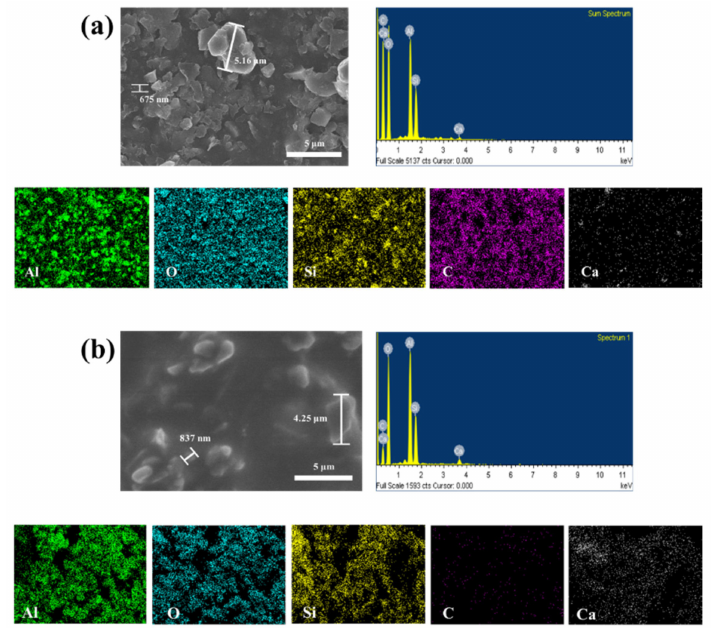
Figure 7. ( a ) FE-SEM image and EDAX spectrum of the ceramic particles at the green body, ( b ) FE-